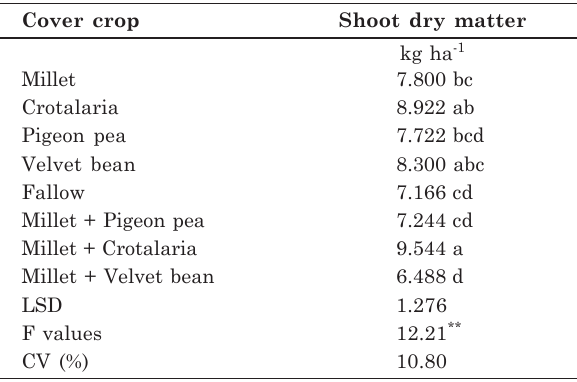
Means followed by the same letter in the column do not differ by Tukey’s test at 5 %. ** : : significant at 1 %. LSD: least significant difference; CV: coefficient of